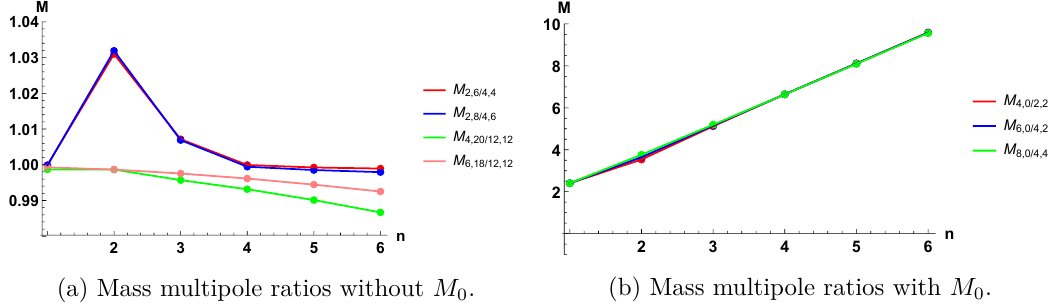
Figure 4. Mass multipole ratios computed from symmetric pincers ( n, n ) with n = 1 , · · · , 6 (section